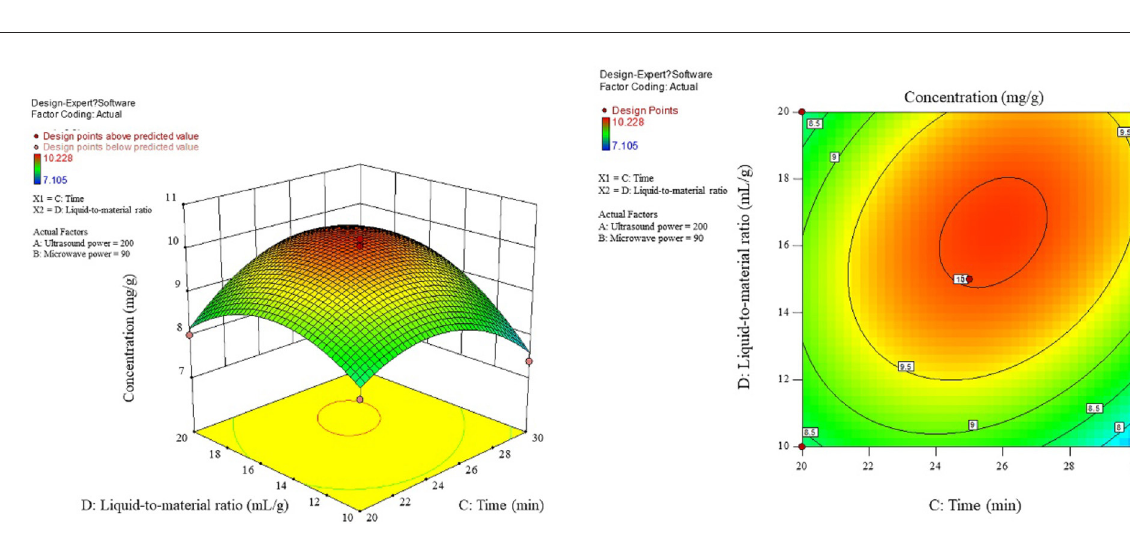
FIGURE8 Effect of the interaction of extraction time and liquid-to-material ratio on content.